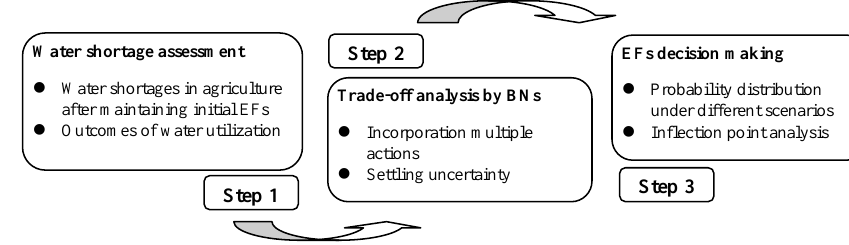
Fig. 1. Steps for environmental flow (EF)